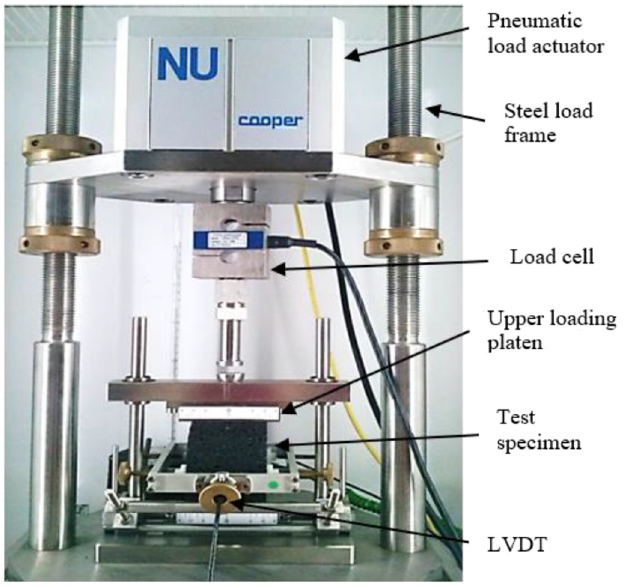
Fig. 1. Test equipment of the rigidity modulus (EN 12697 –